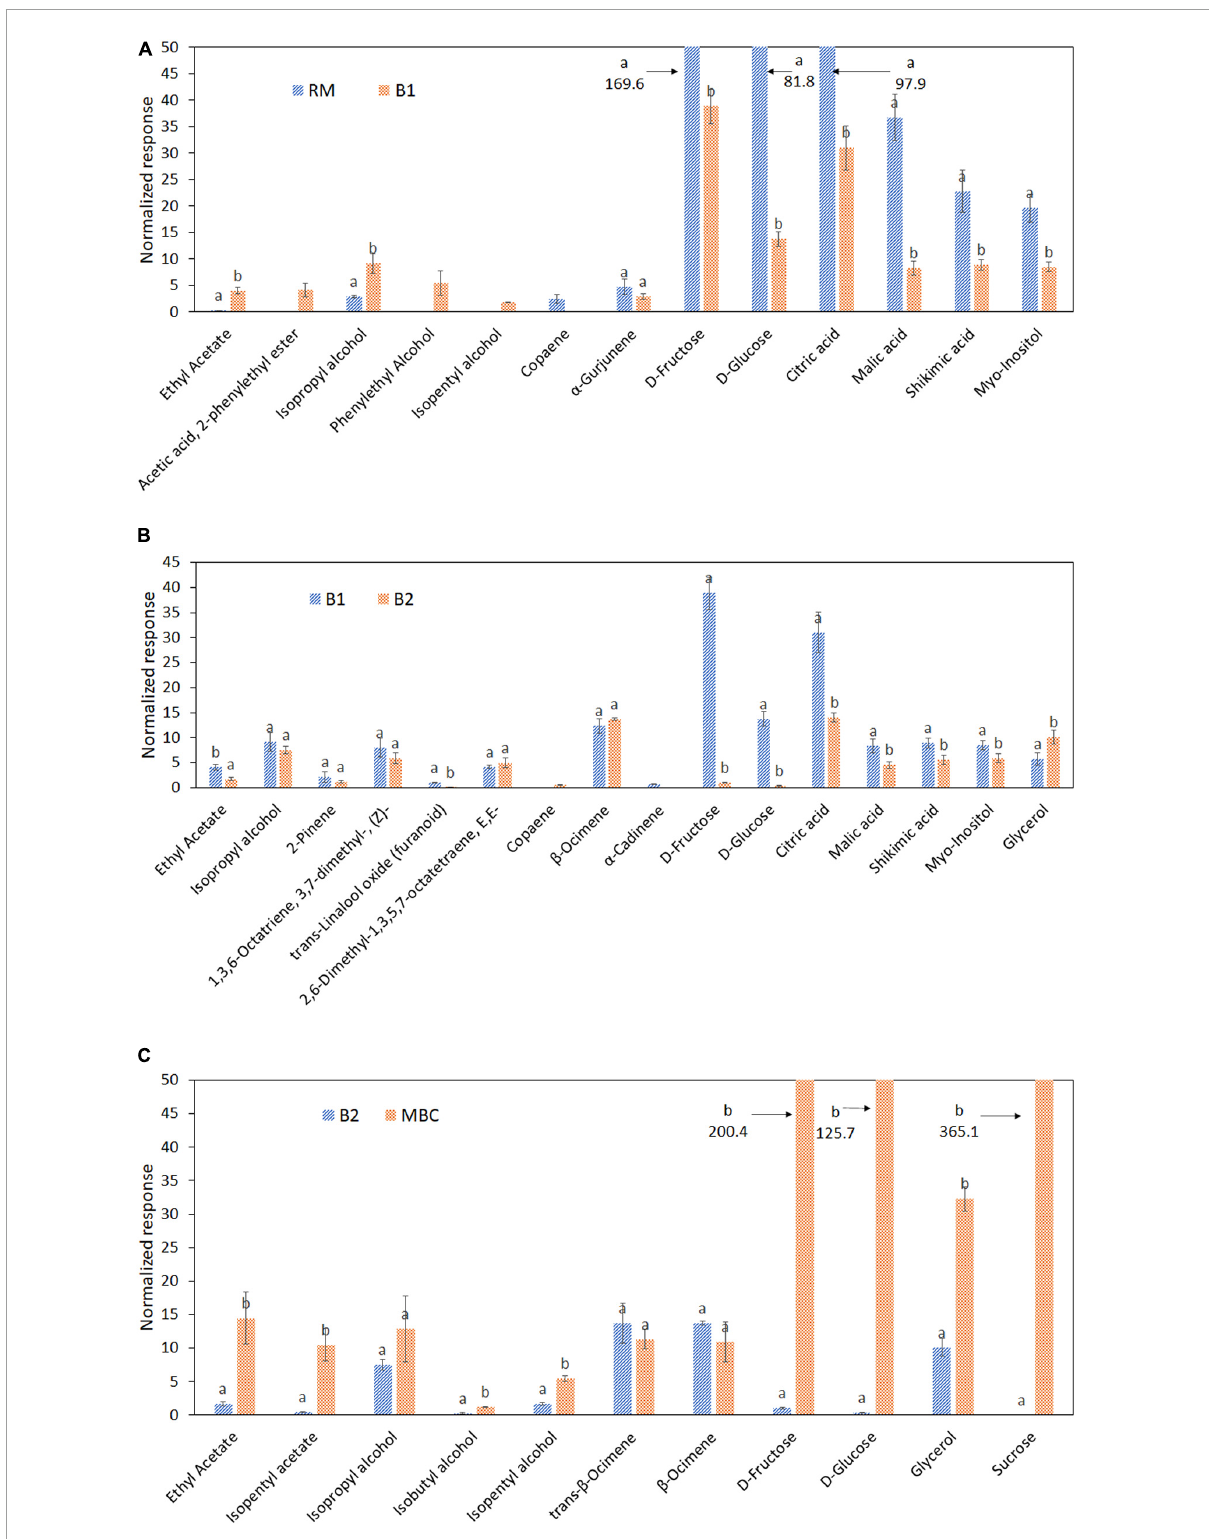
FIGURE5 Discriminant metabolites of raw mango (RM), after brining 1 (B1), after brining 2 (B2), and MBC (final product) in each immersion process: S1 (A) , S2 (B) , and S3 (C) . Different letter indicates a significant difference (independent t -test, α = 0.05). Mean value ± standard deviation was used ( n =